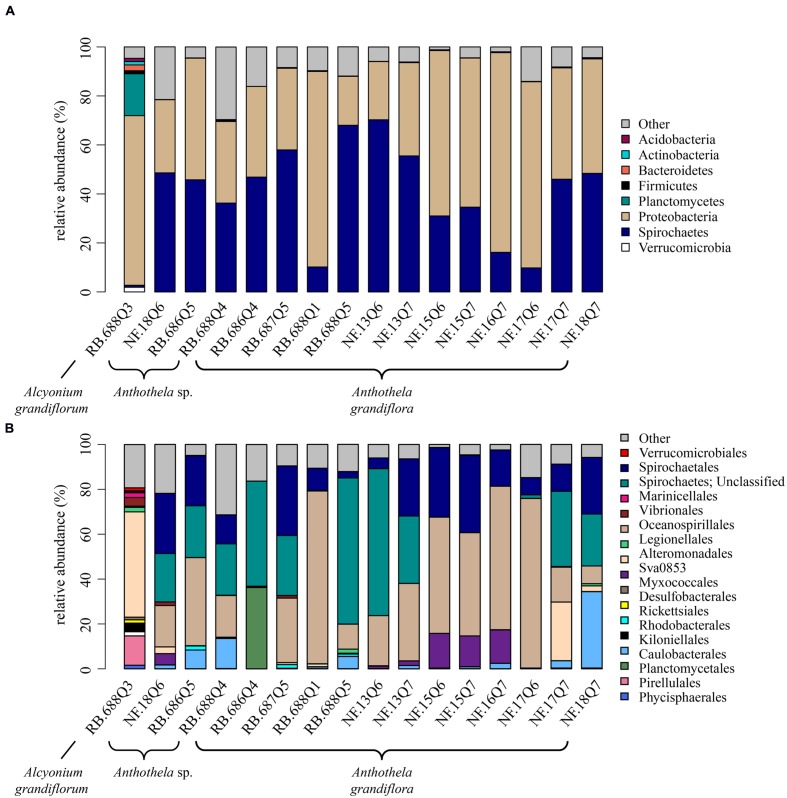
Relative abundance of bacterial taxa in coral samples. (A) Phyla present at ≥1% relative abundance in at least one sample. All remaining taxa are summarized under “Other.” (B) Orders present at ≥1% relative abundance in at least one sample. All remaining taxa are summarized under “Other.” Samples collected from Baltimore Canyon begin with the letters “NF” and those from Norfolk Canyon with “RB.”